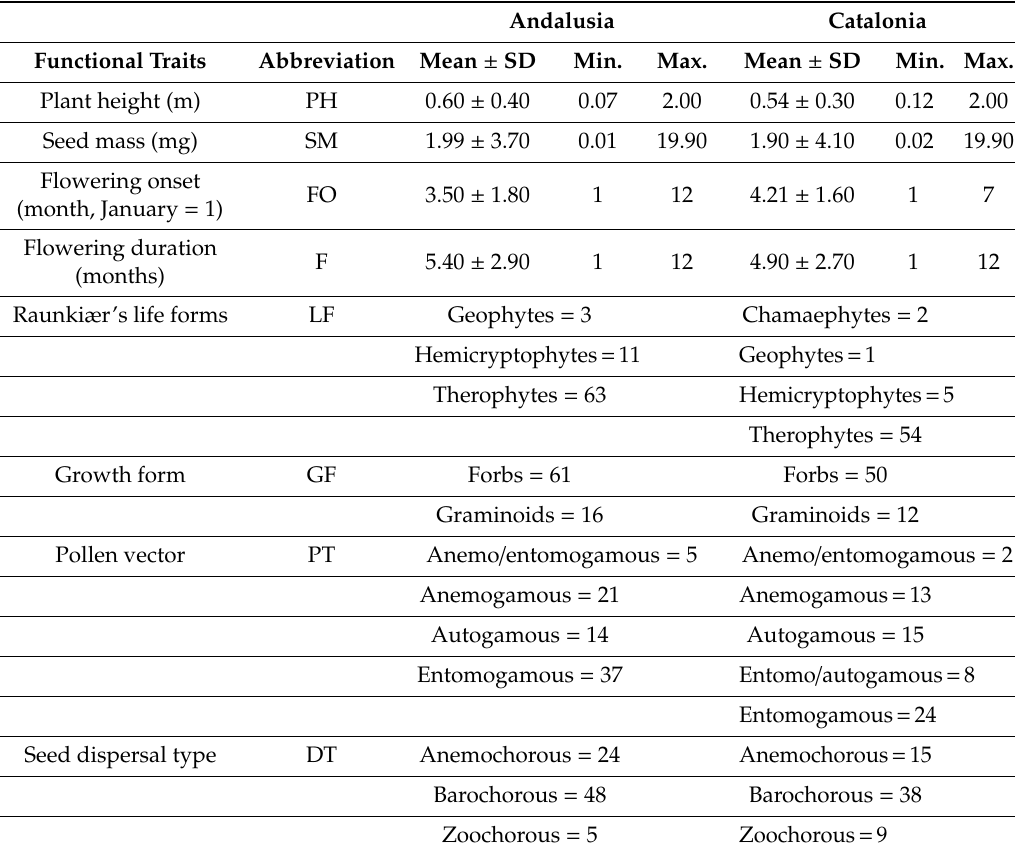
Table 2. Mean ± standard deviation (SD) and minimum and maximum values of the eight functional traits of seed bank communities of conventionally managed cereal fields in Andalusia and Catalonia. Only species with occurrence frequency ≥ 5% were included in the